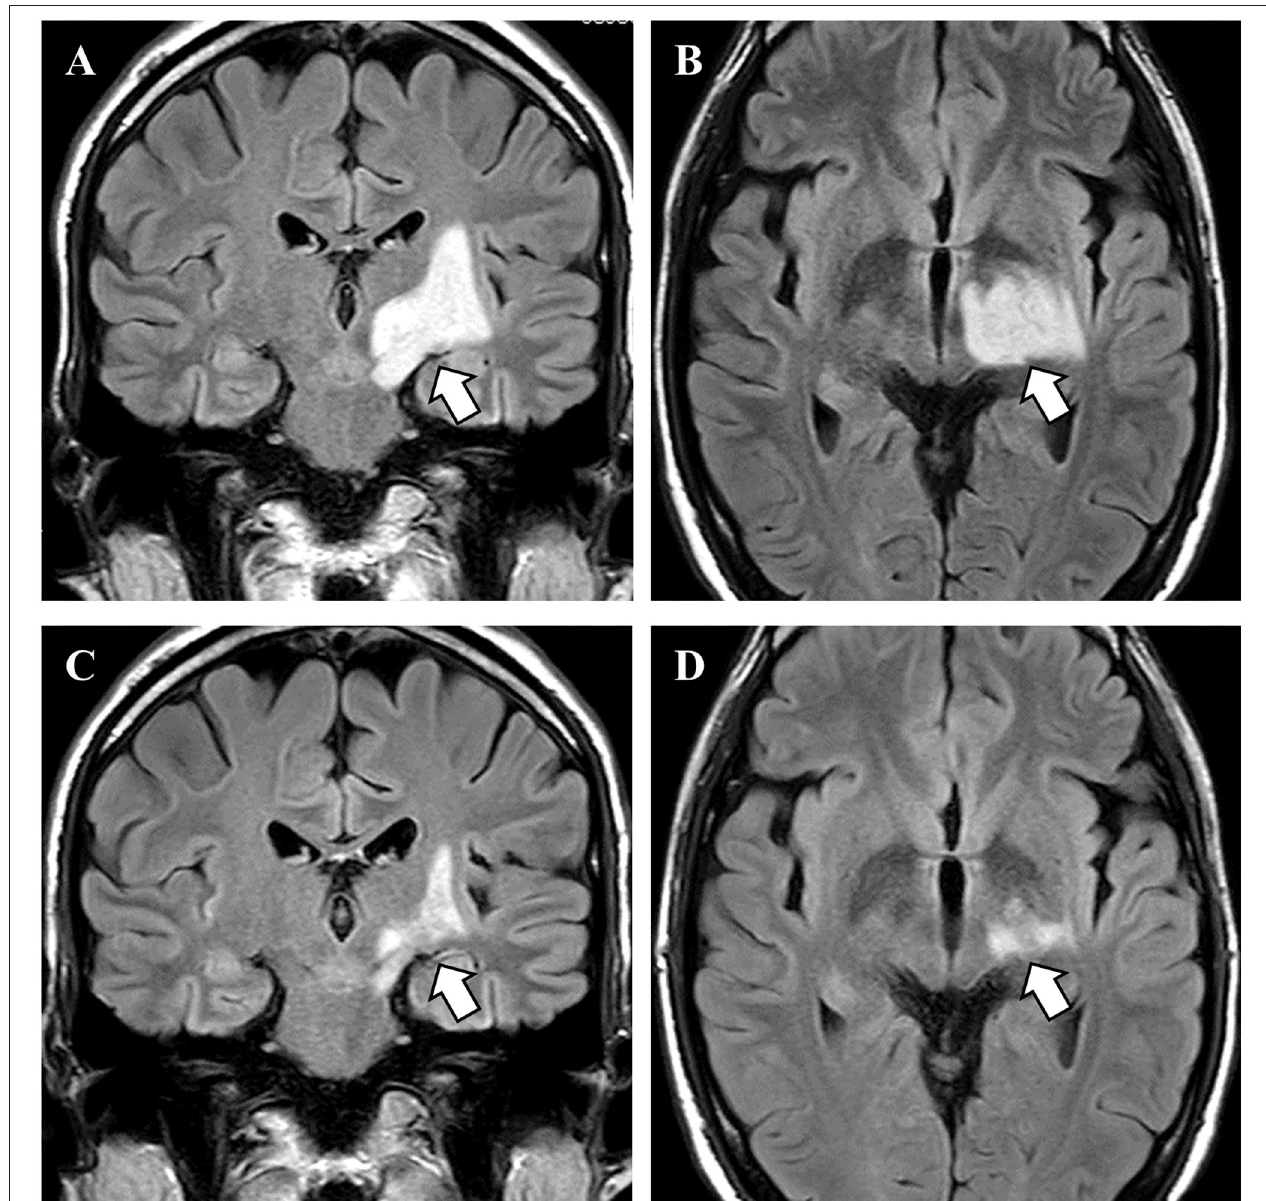
FIGURE 3 | MRI findings before and after treatment. (A,B) Before treatment, brain magnetic resonance imaging showed a high-intensity lesion in the left basal ganglia (arrows). (C,D) After chemotherapy and immunotherapy, the brain lesion was reduced in size (arrows).